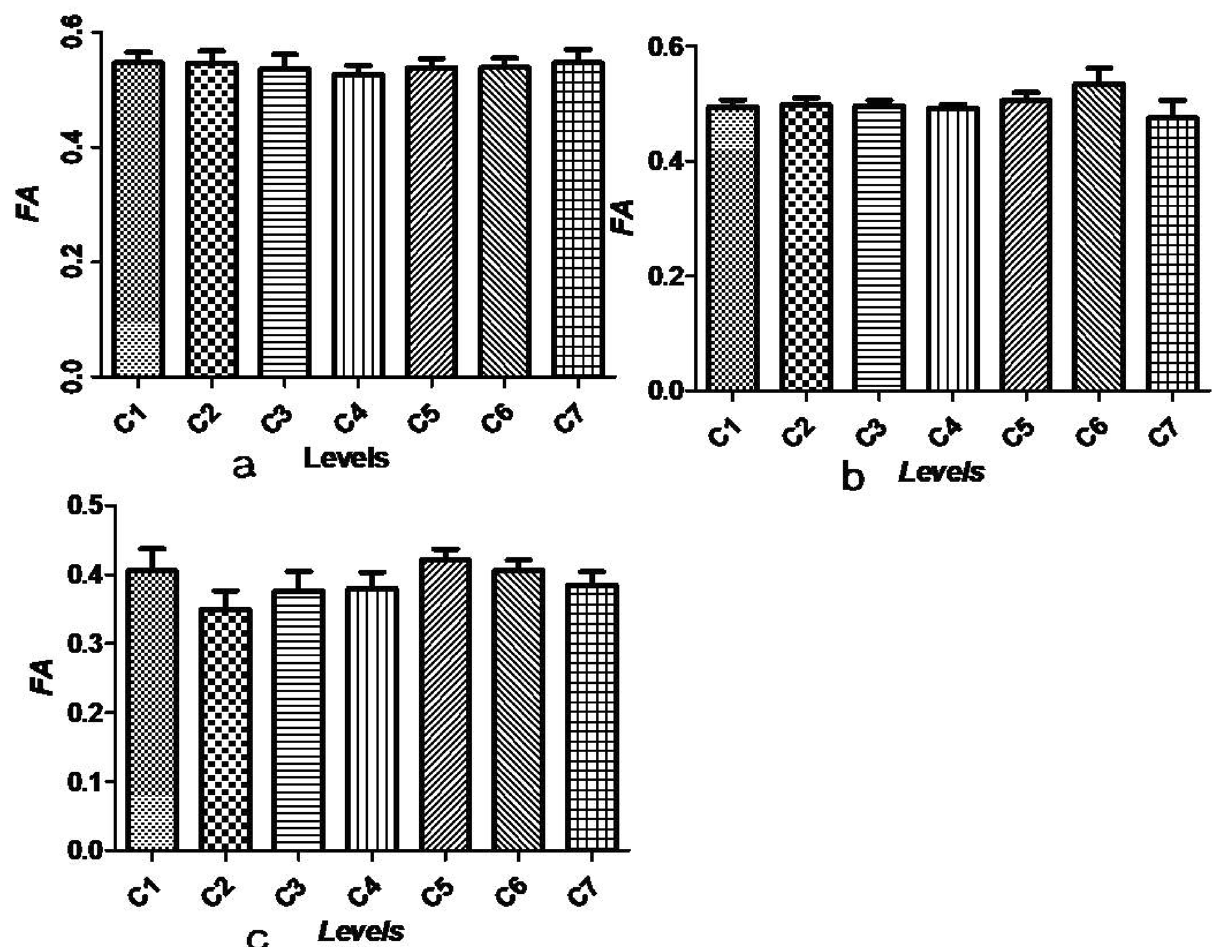
Figure 2. ( a – c ) FA values (mean ± SEM) at all cervical levels in controls, outside the area of the visible syrinx and the area of the visible syrinx,